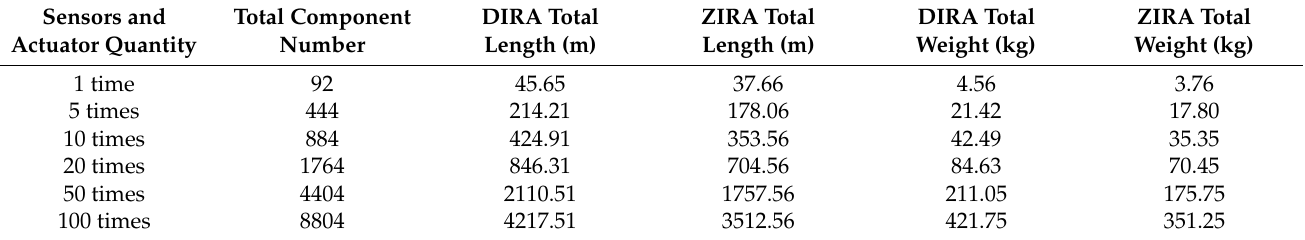
Table 12. The Total Length and Total Weight Comparison of the DIRA and ZIRA Architecture Wiring Harness under different quantities of sensors and